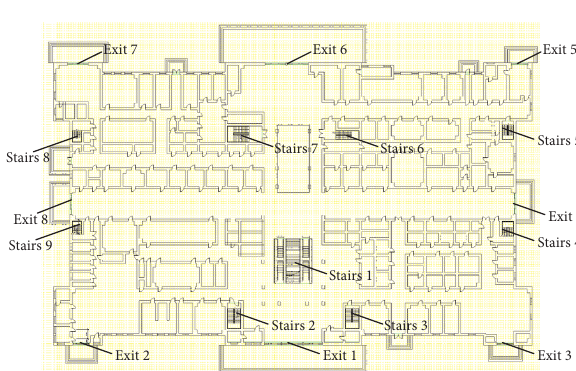
Figure 13: Floor 1 plane structure diagram.